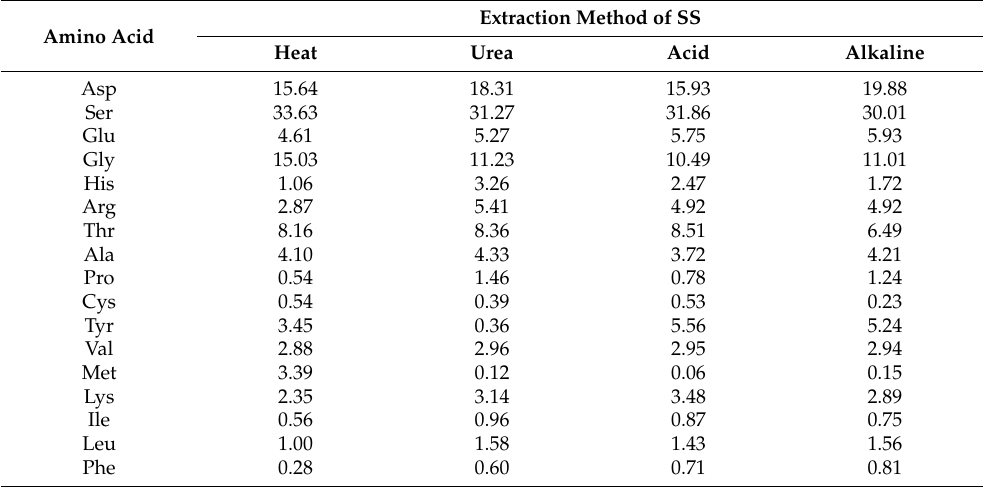
Table 3. Variation in the amino acid composition of sericin with respect to different extraction methods. Amino